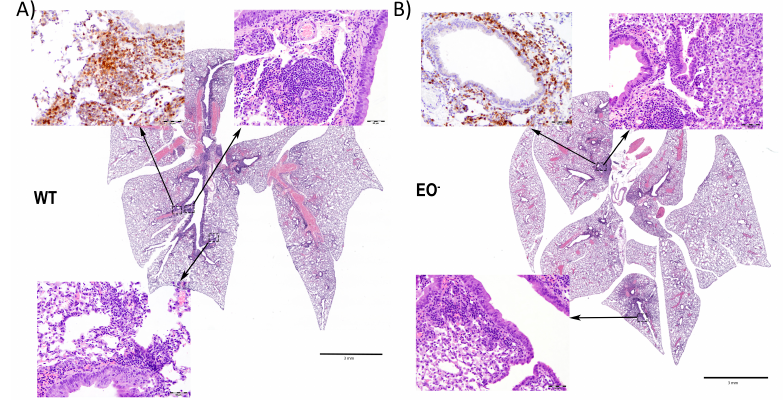
Figure 6. Eosinophil-deficient mice were deficient in generating organized BALT. Groups of 6 Balb / cJ (WT) ( A ) and GATA-1 (EO - ) ( B ) mice were intranasally challenged with 50 μ L of PBS containing 5 × 10 5 Bb D btrS , and, at day seven post-challenge, lungs were fixed in 10% formalin solution for hematoxylin and eosin staining. Scale bar = 3 mm. n = 6.